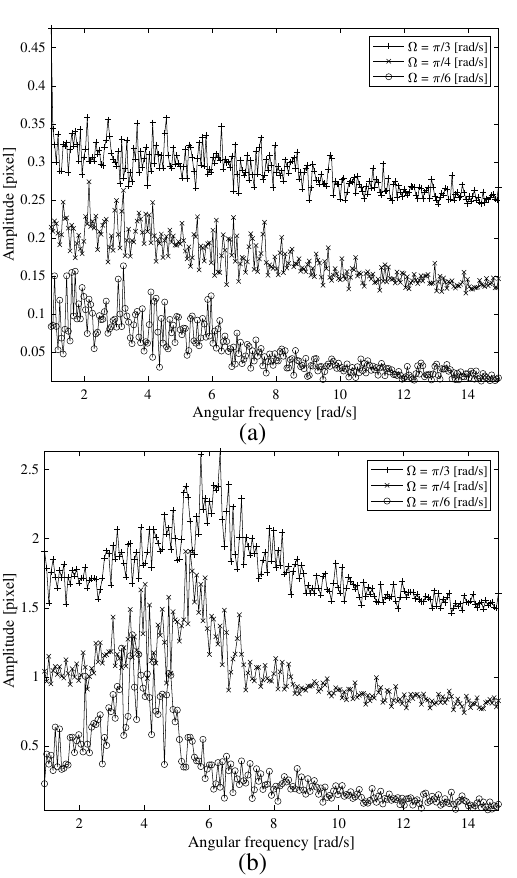
Figure 3. Influence of particle shape: (a) The SSA spectrum for spherical particles in the large drum with ⌦ = ⇡ / 6 [rad / s]; The shifted fitting line (’ + ’ marker) for the 1 / f a -decay has a slope about a = 1 . 0. (b) The SSA spectrum for polyhedral particles in the large drum with ⌦ = ⇡ / 6 [rad / s]; The shifted fitting line (’ + ’ marker) for the 1 / f a -decay has a slope about a = 1 . 4. The vertical dashed line indicates the rotation speed of the drum.